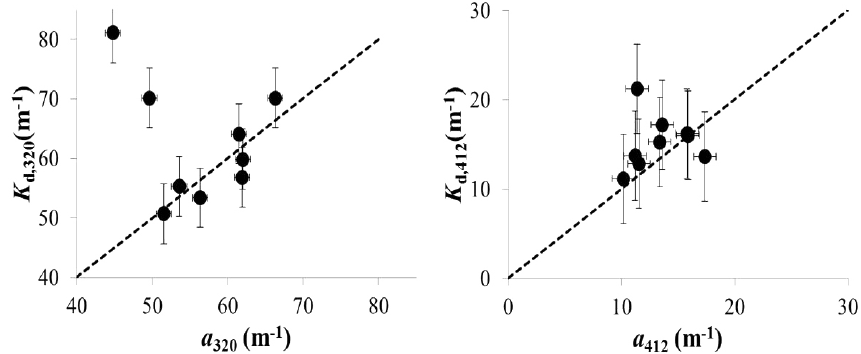
Figure 2. K d ,λ vs. a CDOM ,λ at 320nm (left) and 412 nm (right) plotted vs. 1 : 1 line (dotted line). a CDOM ,λ measured on the laboratory spectrophotometer was corrected for the average cosine of downwelling radiation for the time of day (i.e., zenith angle) that the in situ K d ,λ values were measured in Imnavait Creek. Thus a CDOM ,λ values in this figure are not directly comparable to the values presented in Tables 2 and